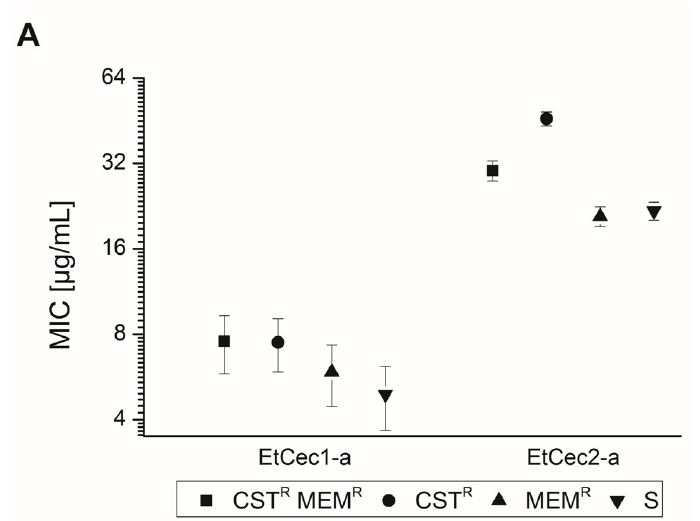
Figure 1. Activity of EtCec1-a and EtCec2-a against colistin/meropenem-resistant (CST R MST R ; squares), colistin-resistant